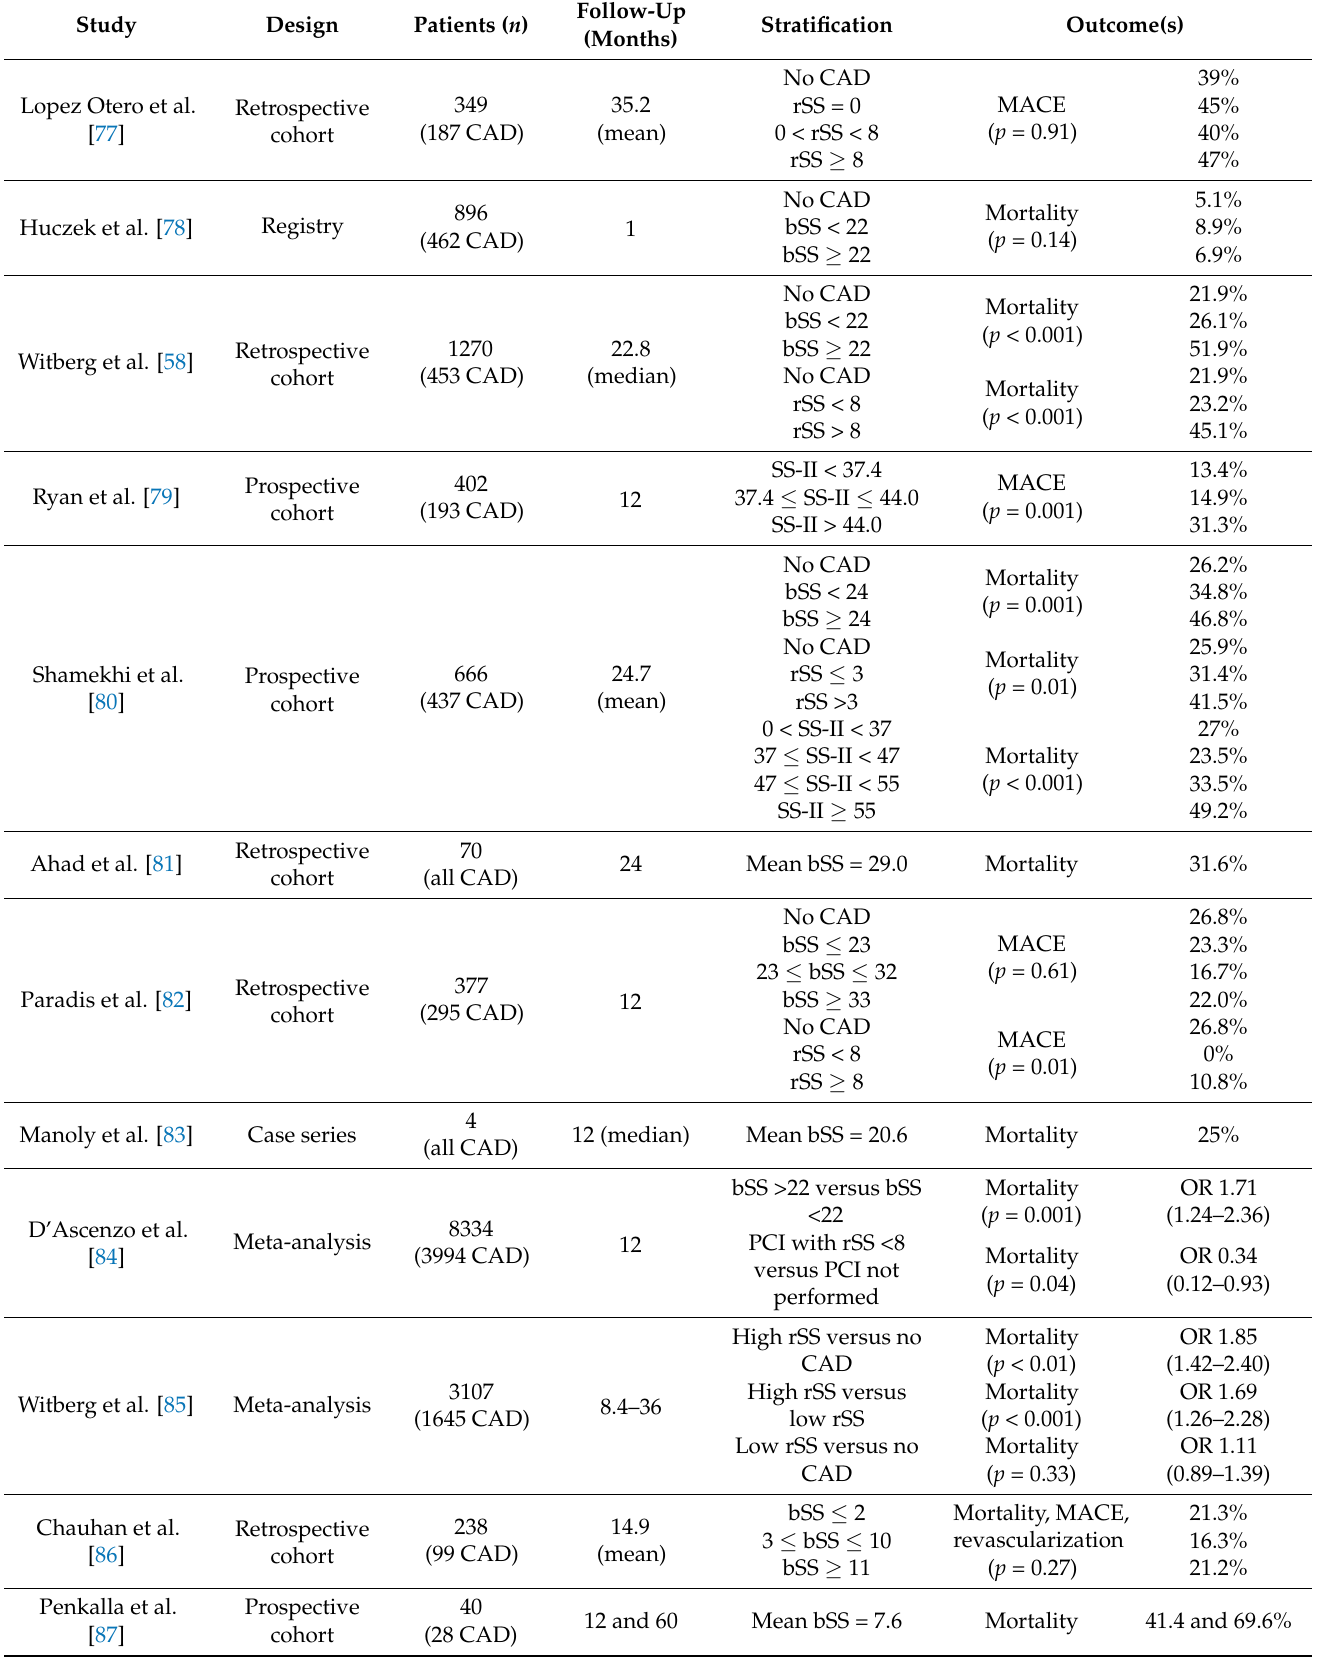
Table 3. Prognostic impact of CAD in TAVI